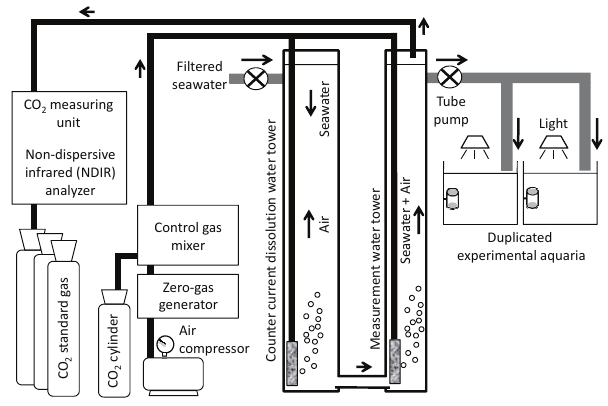
Fig. 1. The schematic diagram of culturing set-up. See the text for